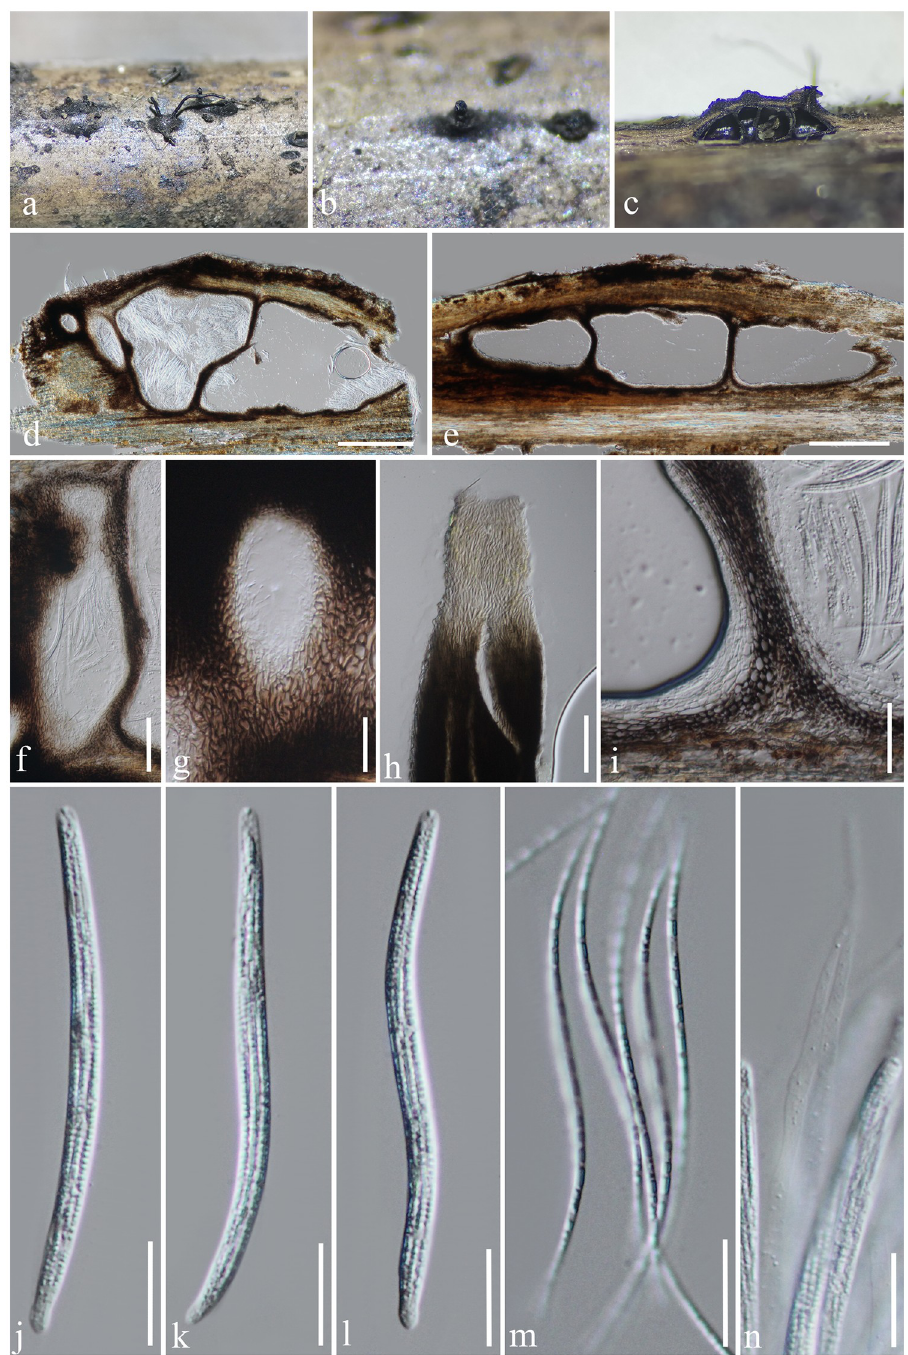
Fig 2. Ophioceras sichuanense (KUN-HKAS 107677, holotype). a, b Pseudostromata with long ostiolar necks on host. c–e Section through pseudostromata. f Ascoma. g Ostiole. h Apical part of neck. i Peridium. j–l Asci. m Ascospores. n Paraphyses. Scale bars: d, e = 200 μ m, f–h = 50 μ m, i = 30 μ m, j–n = 20 μ m.